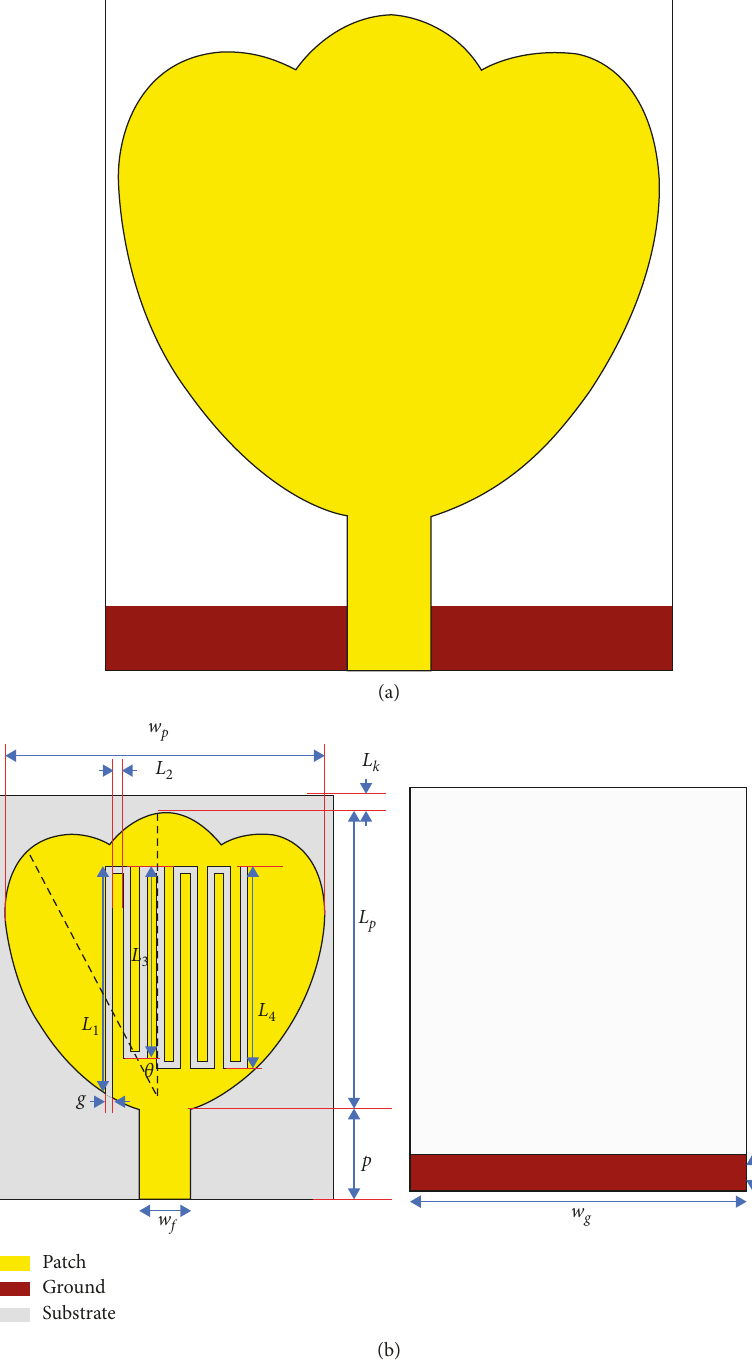
Figure 1: (a) Proposed MSB antenna initiator, (b) proposed MSB antenna